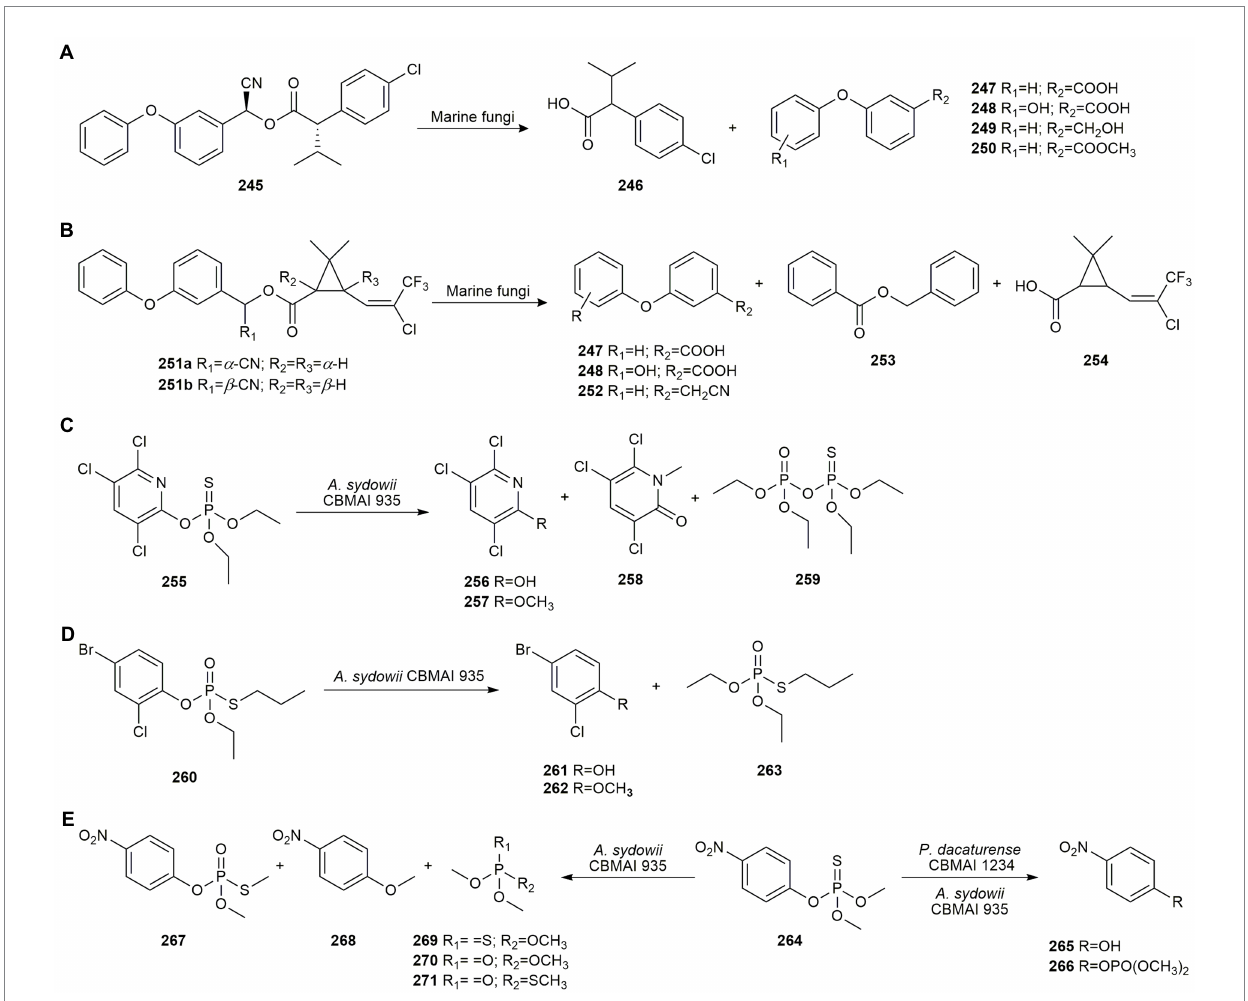
FIGURE 12 Pesticide biodegradations. (A) Esfenvalerate ( 245 ) biodegradation by marine fungi (Birolli et al., 2016) (B) Biodegradation of (±)-lambda-cyhalothrin ( 251 ) enantiomers by Aspergillus sp. CBMAI 1829, Acremonium sp. CBMAI 1676, Microsphaeropsis sp. CBMAI 1675, and Westerdykella sp. CBMAI 1679 (Birolli et al., 2018b). (C) Chlorpyrifos ( 255 ) biodegradation by Aspergillus sydowii CBMAI 935 (Soares et al., 2021). (D) Profenofos ( 260 ) biodegradation by A. sydowii CBMAI 935 (Soares et al., 2021). (E) Bioremediation of methyl parathion ( 264 ) by Penicillium decaturense CBMAI 1234 and A.